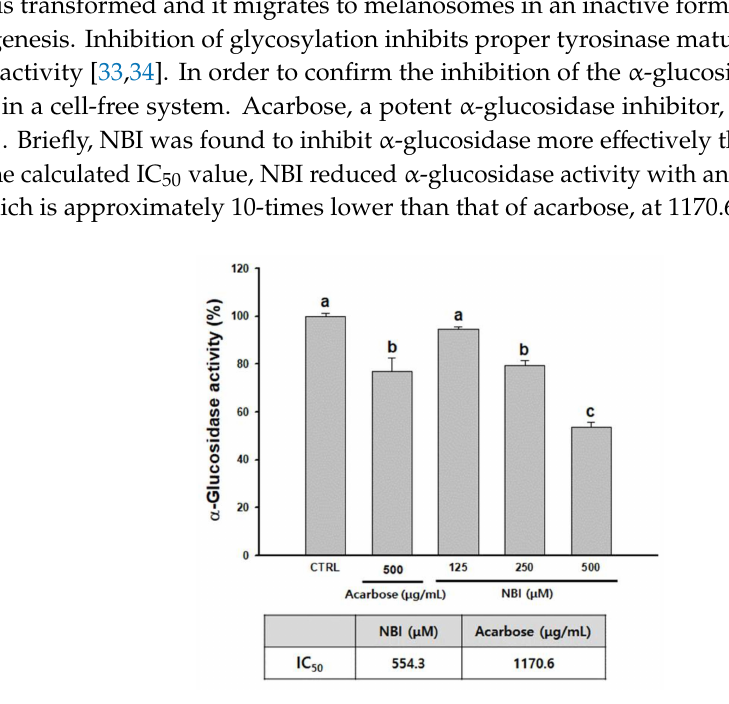
Figure 5. Inhibitory e ff ects on α -glucosidase activity. Each percentage value representing α -glucosidase activity is reported relative to that of the control. Data are presented as mean ± SD. Values with di ff erent letters (a, b, c) are significantly di ff erent one from another (one-way ANOVA followed by Tukey’s multiple range test, p <